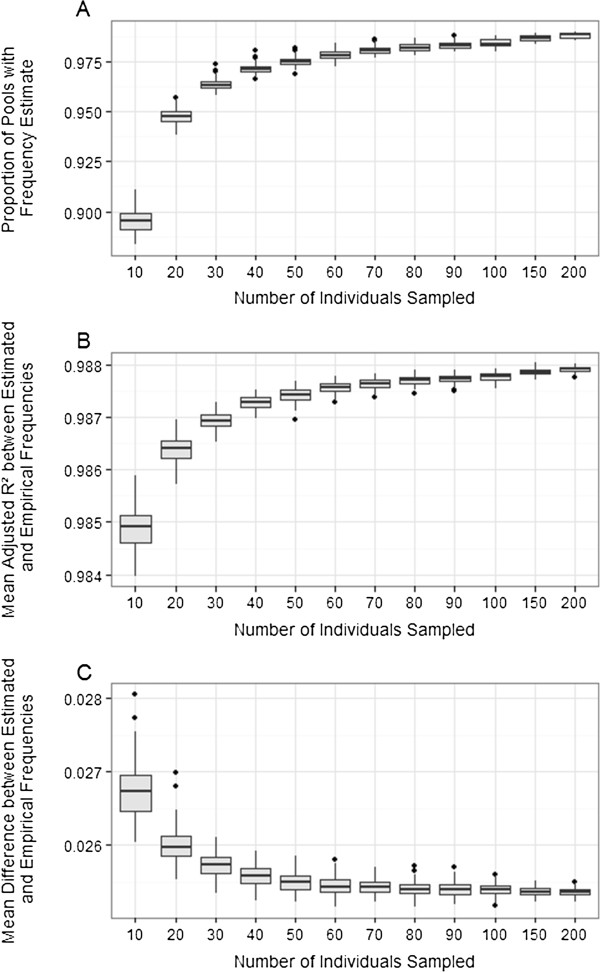
Boxplot demonstrating the accuracy of allele frequency estimation using subsets of reference individuals. Parameter estimation was carried out 100 times for each subset. A. The proportion of pooled samples for which frequency estimates could be calculated. B. The mean adjusted R2 over all pools and all loci for each simulation. C. The mean difference between empirical and estimated allele frequencies over all pools and loci for each simulation.